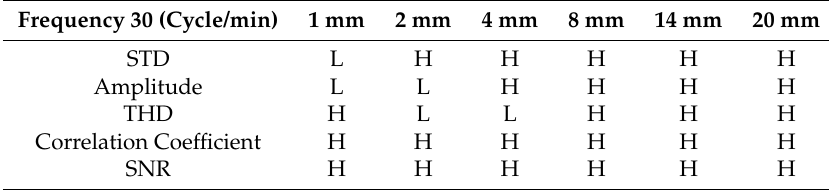
Table A5. Values higher and lower than the median Frequency 30 cycles/min for a 2 mm